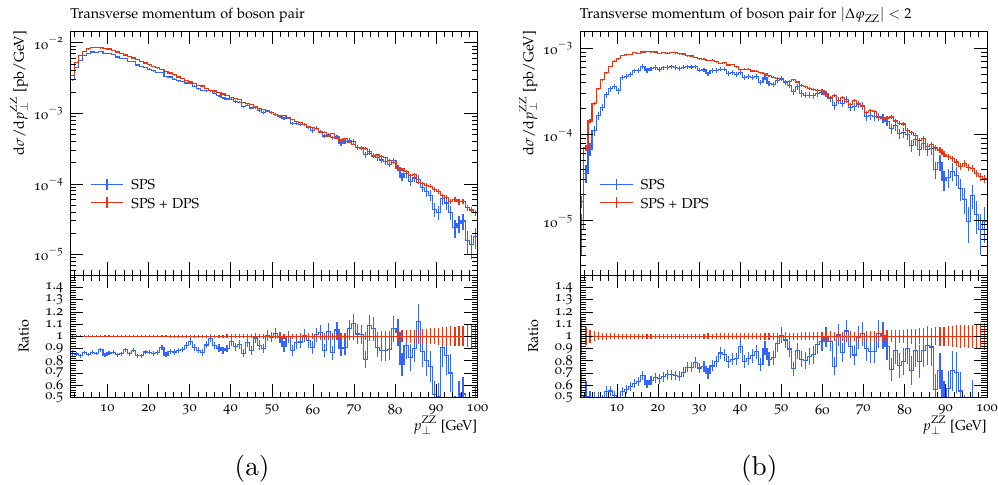
Figure 18 . (a) Transverse momentum of the Z 0 Z 0 pair and (b) transverse momentum of the pair with a cut on the azimuthal di(cid:11)erence for the production via SPS only and via SPS combined with DPS. The SPS+DPS setup is the reference in the ratio plots. The histograms are not normalised to